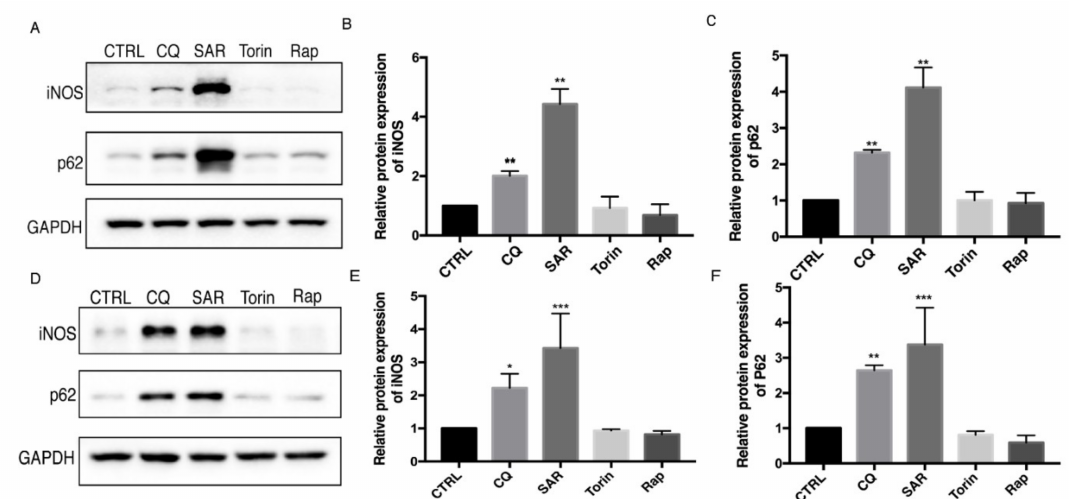
Figure 1. Autophagy inhibition lead to iNOS and p62 accumulation in Raw 264.7 and bone marrow-derived macrophages (BMDM). ( A , D ) Raw 264.7 cells ( A – C ) and BMDMs ( E – F ) were incubated with CQ (30 µ M), SAR (1 µ M), Torin (1 µ M), Rap (1 µ M) for 24h. iNOS, p62 levels were detected by western blotting. CTRL is blank control group with DMSO treatment. ( B , E ) Western blot analysis of iNOS in Raw 264.7 cells and BMDM cells under basal condition. ( C , F ) Western blot analysis of p62 in Raw 264.7 cells and BMDM cells under basal condition. ( B – F ) Values were analyzed from three individual experiments by GraphPad Prism, each experiment conducted three times. * p < 0.05,